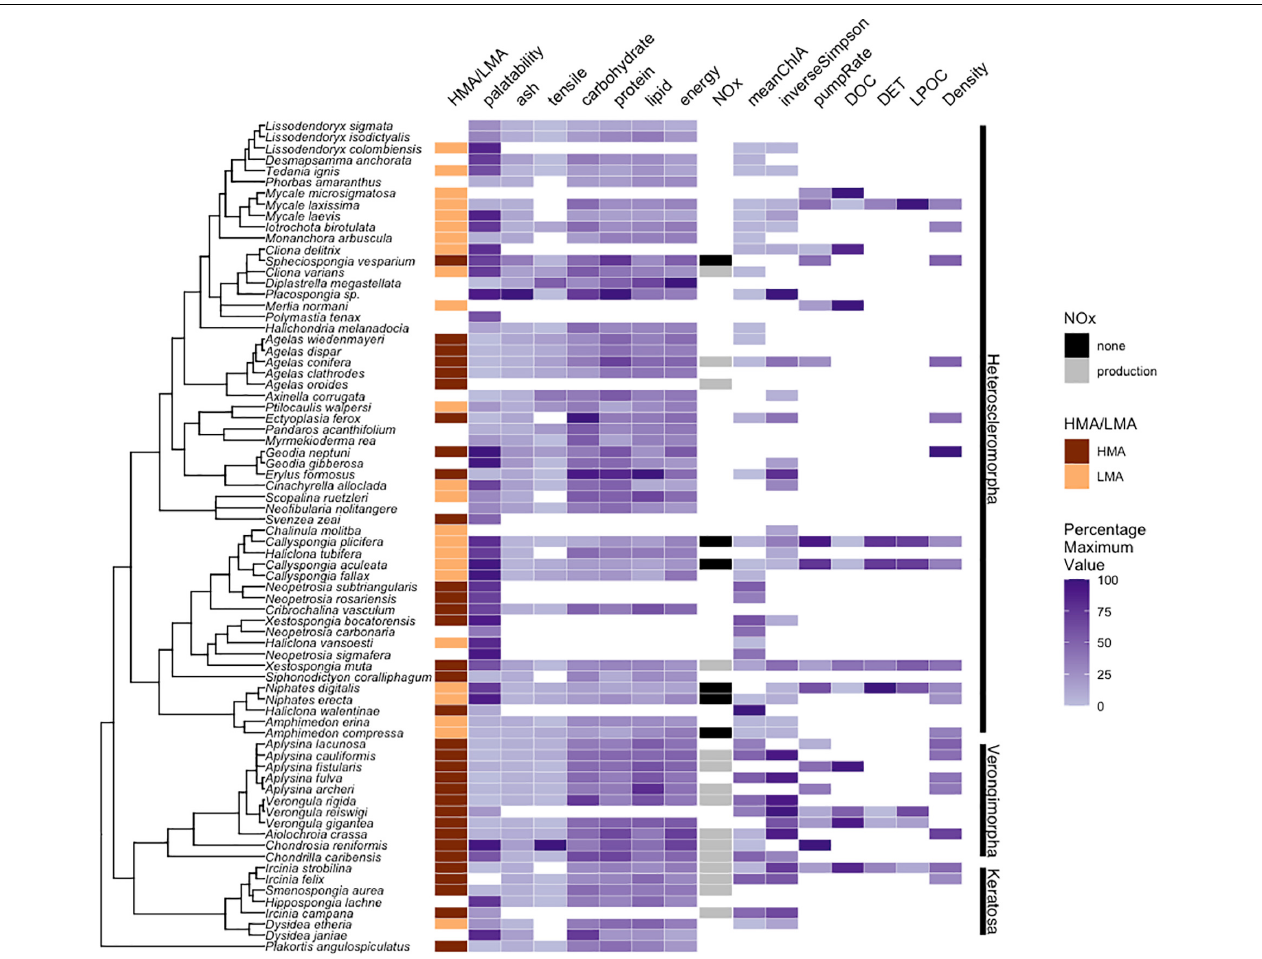
FIGURE 5 | Major life history traits of sponges plotted against a phylogeny of common Caribbean species. Discrete traits include HMA/LMA status and NO x production. Continuous traits are displayed as a percentage of the maximum value of each trait. Vertical bars to the right indicate subclasses of class Demospongiae; Plakortis is a member of class Homoscleromorpha; palatability (mean number of pellets containing sponge chemical extracts that were consumed in trials with the bluehead wrasse Thalassoma bifasciatum ; Loh and Pawlik, 2014), physical characteristics (ash, carbohydrate, protein, and lipid [mg ml - 1 ], tensile strength [N m - 2 × 10 5 ], and energy [KJ ml - 1 ] from Chanas and Pawlik, 1995), Chla, mean chlorophyll a concentrations ( µ g chl a g spongetissue - 1 ); inverseSimpson, value of the inverse Simpson’s index for microbiome diversity; pumpRate, pumping rate of water through a sponge (l s - 1 l sponge - 1 ); DOC, DET, and LPOC, percent dissolved organic carbon, detritus, or living particulate organic carbon in diet, and Density = mean tissue density (g ml - 1 ). Analyses adapted from those in Freeman et al. (2020) using data and related references in tables within Supplementary Information